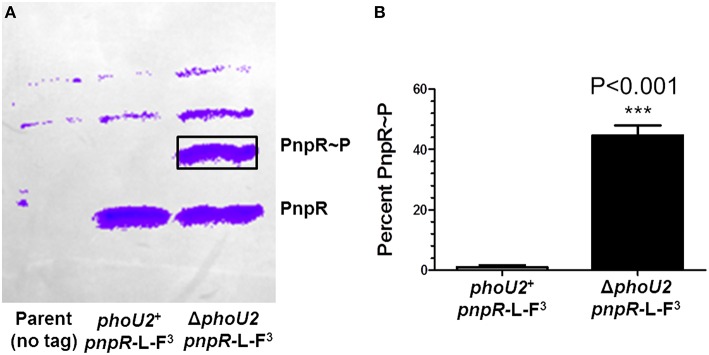
Approximately 45% of PnpR is phosphorylated (PnpR~P) in a ΔphoU2 mutant. (A) Representative Phos-tag SDS-PAGE of the encapsulated parent strain not expressing a FLAG-tagged protein (IU1781, lane 1) and of the pnpR-L-FLAG3 (IU6689, lane 2), and ΔphoU2 pnpR-L-FLAG3 (IU6687, lane 3) mutants growing exponentially in BHI broth. The gel was Western blotted with anti-FLAG antibody as described in Materials and Methods. The top two bands in all lanes are nonspecific. The upper anti-FLAG-specific band corresponds to phosphorylated PnpR~P, and the lower band corresponds to unphosphorylated PnpR. Control experiments show that the upper band is heat-sensitive, as expected for PnpR~P (Figure S4). (B) Quantification of 3 independent Phos-tag SDS-PAGE experiments. Less than 1% of PnpR was phosphorylated in the phoU2+ strain, whereas ≈45% of PnpR is phosphorylated (PnpR~P) in the ΔphoU2 mutant. P-value was determined by an unpaired t-test in GraphPad Prism; ***P < 0.001.